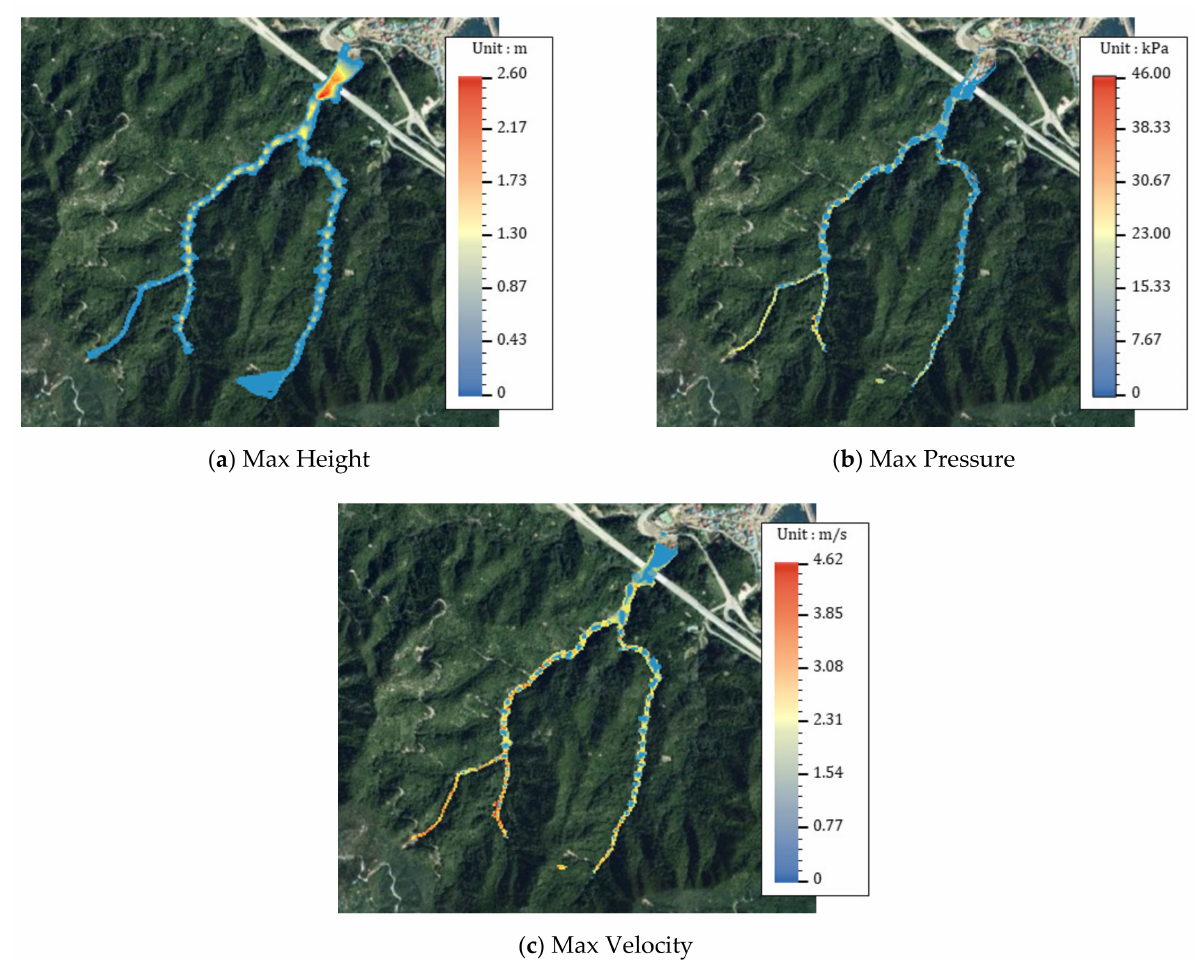
Figure 13. Results of RAMMS using HQPF—Event I. ( a – c ) are the Max Height (m), Max Pressure (kPa), and Max Velocity (m/s) in the modeling results of the debris flow in Sinnam Village,